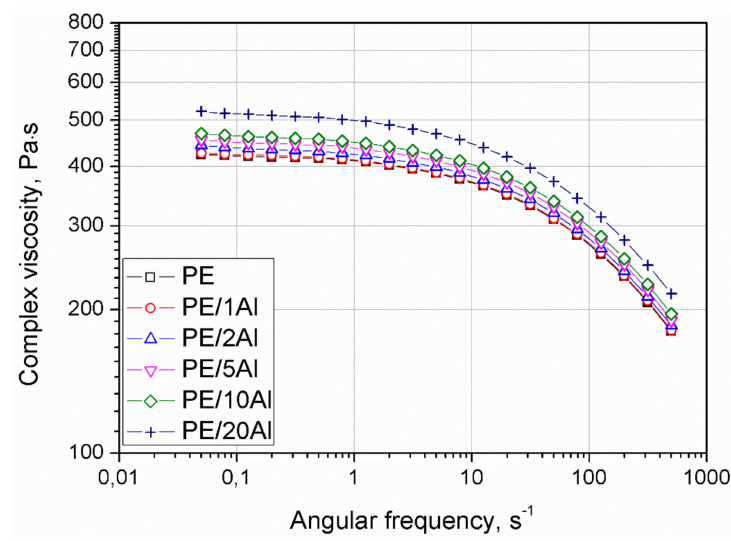
Figure 9. Complex viscosity as a function of angular frequency of PE and PE / Al composites.